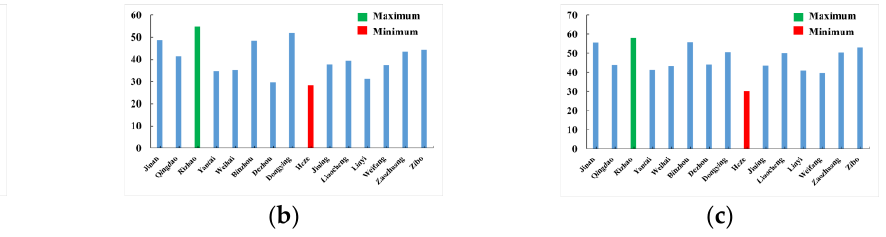
Figure 2. Assessment of ecological livability index in Shandong: ( a ) UGR, ( b ) UPR, and ( c ) ELI.